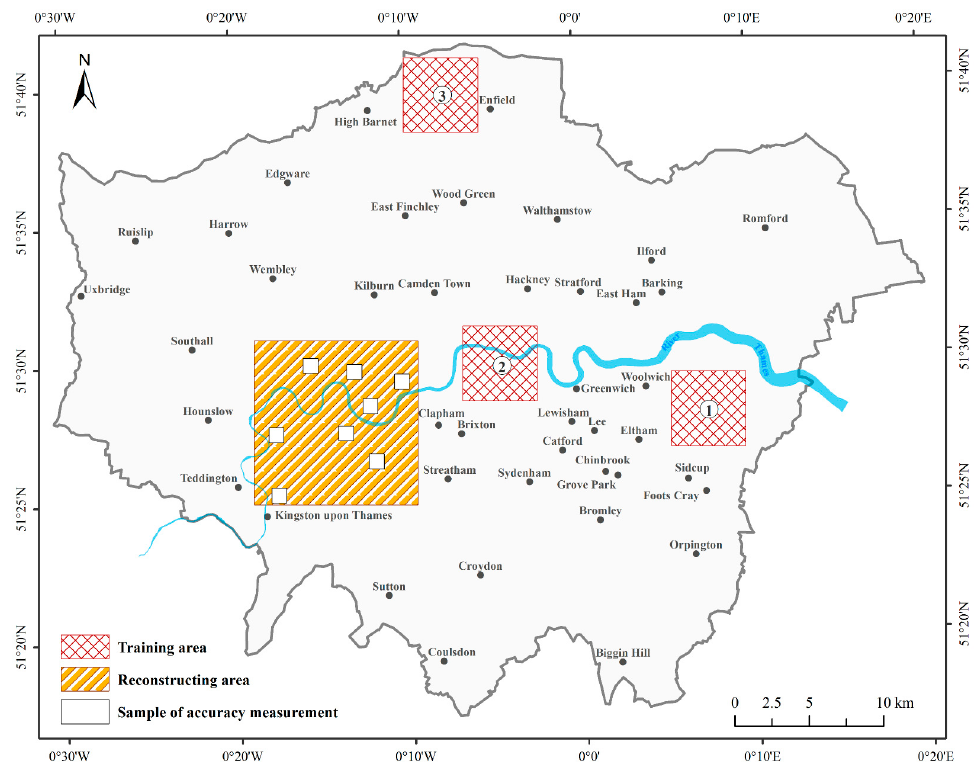
Figure 4. Location of study area.